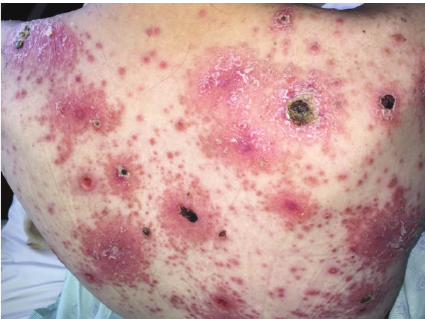
Figure 1: Photograph of the patient’s back demonstrating an erythematous skin eruption with patches of desquamation, plaques, and papules.